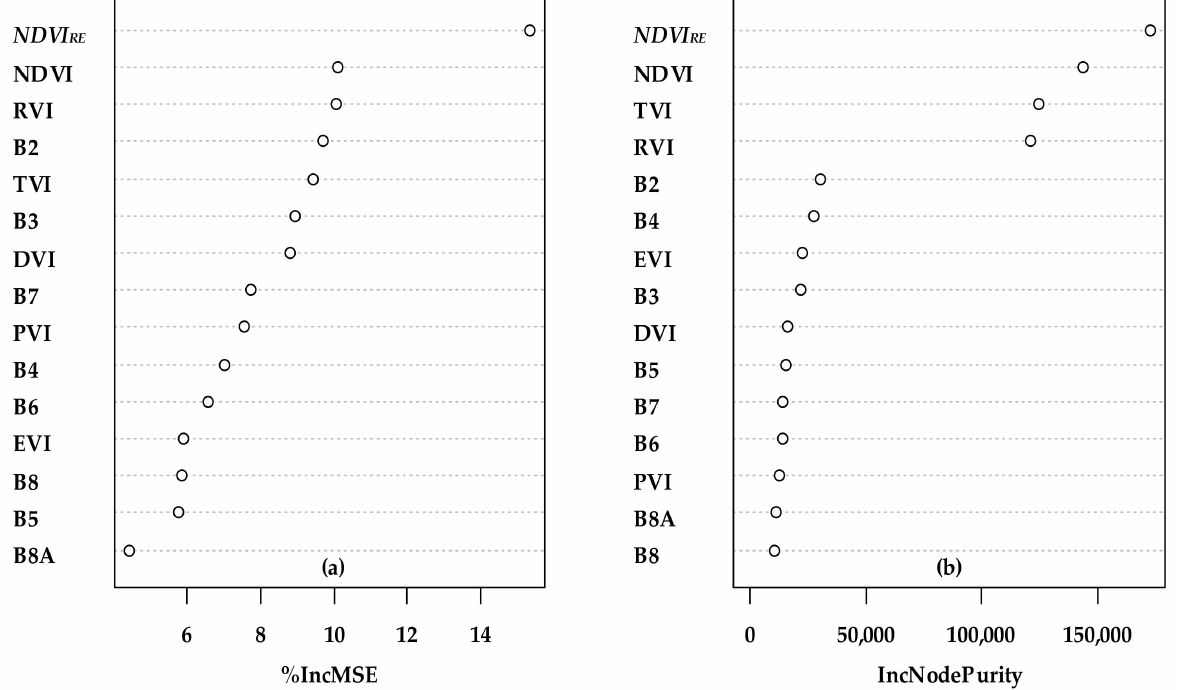
Figure 6. Importance ranking plot of all variables. Left, %IncMSE (percentage increase in the mean square error, ( a )), and right, IncNodePurity (increase in NodePurity, ( b